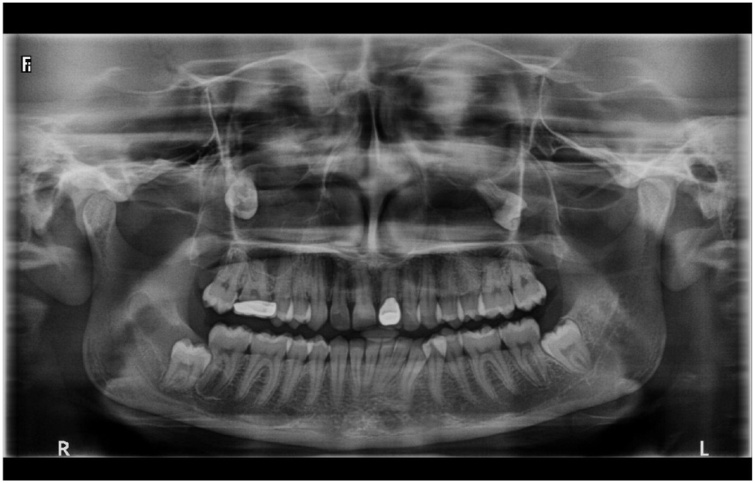
Orthopantomograph.